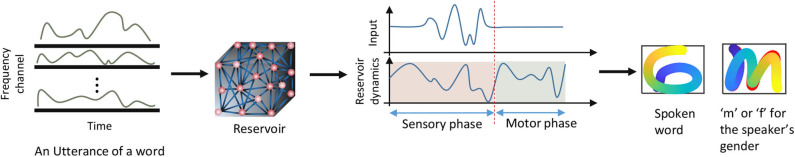
The inputs and outputs of the recurrent network. The network dynamics are divided in to two phases. Sensory phase during which the input is applied, and the motor phase during which two motor patterns are generated.